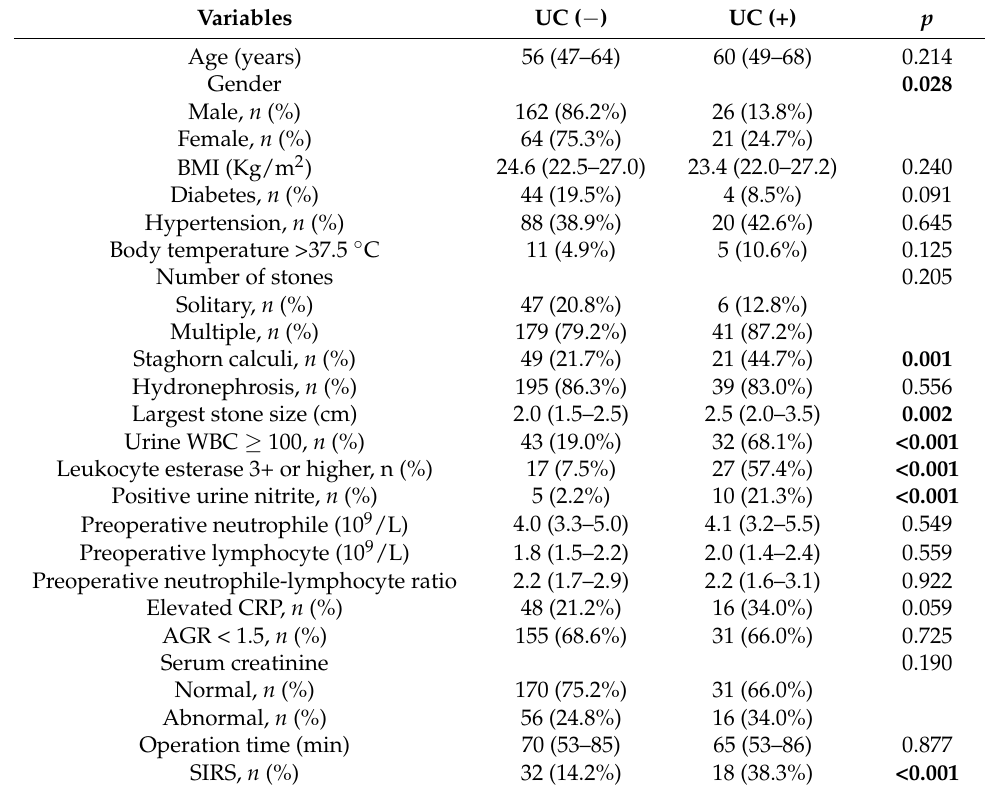
Table 1. Clinical and preoperative factors between UC ( − ) and UC (+) groups.